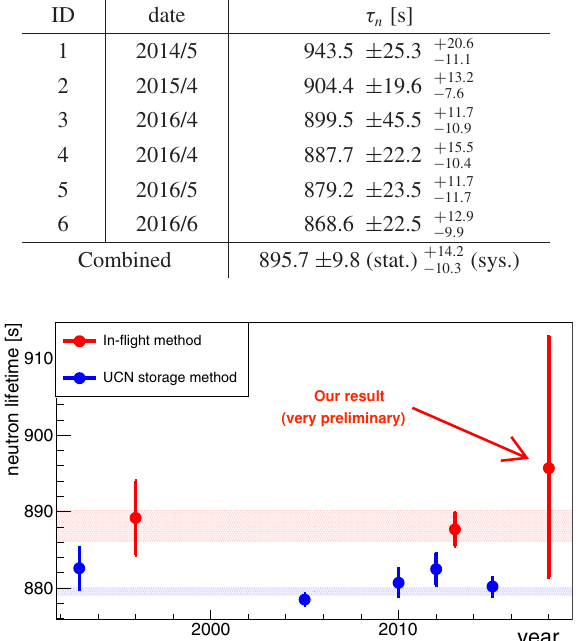
Table 4. Neutron lifetime results from all the data taken between 2014 and 2016 (very preliminary).